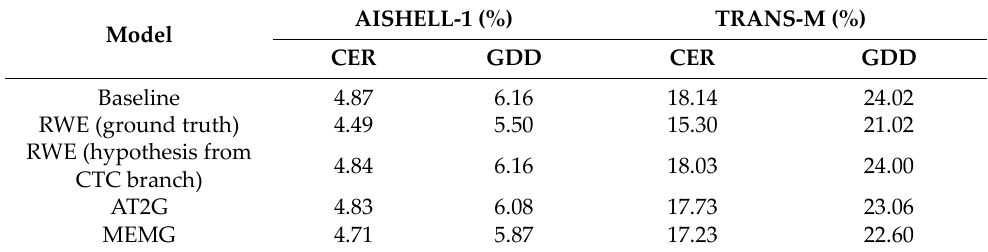
Table 3. The CER and GDD of the proposed system on two test sets.